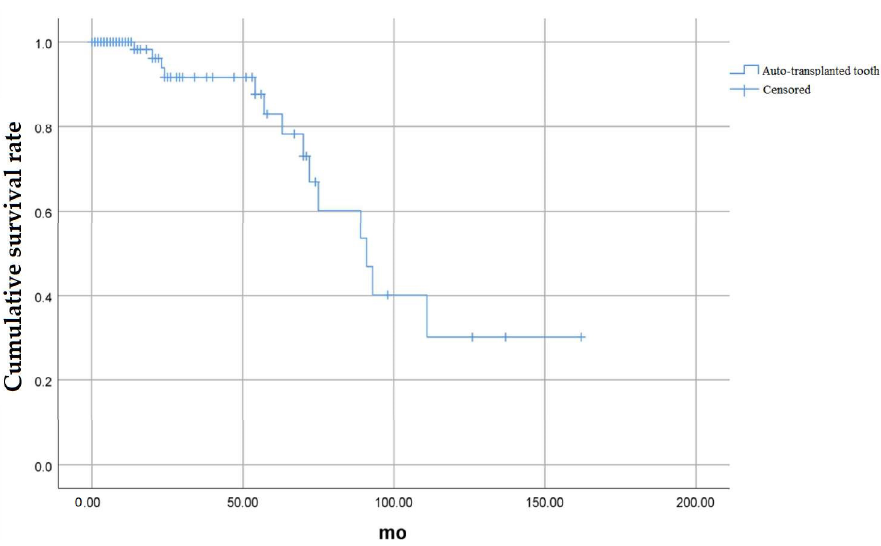
Figure 2. Overall cumulative survival rate of auto-transplanted tooth.